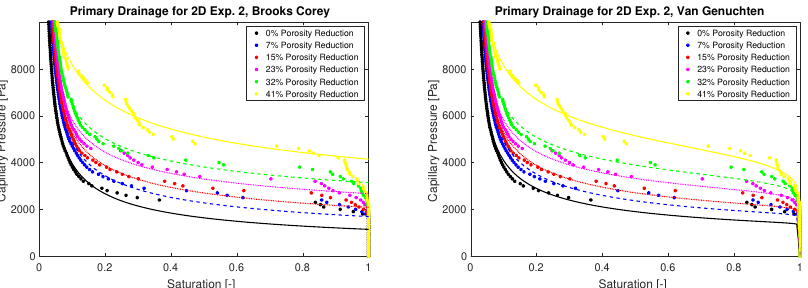
Figure 7. Capillary pressure–saturation relations for Experiment 2D2 at various porosity reductions as fitted with Brooks–Corey (Equation (4)) ( left ) and Van Genuchten relation (Equation (5)) ( right ).